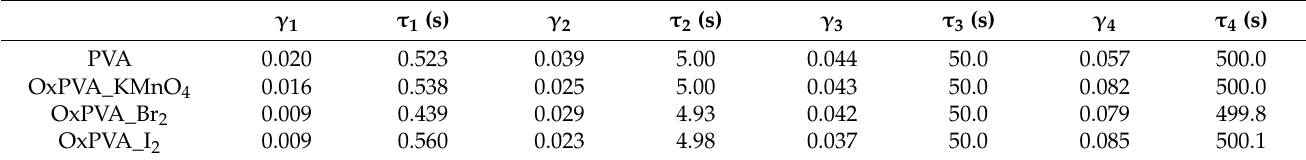
Table 1. Relaxation moduli and time constants of native and oxidized PVA